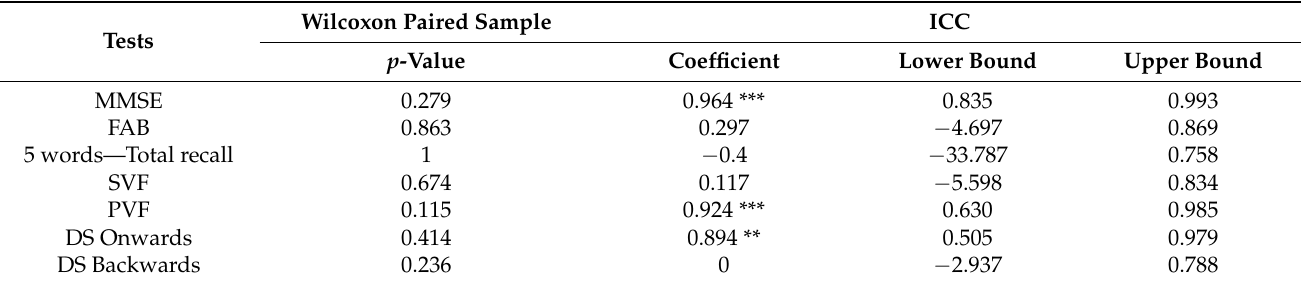
Table 3. Differences and agreement of scores between MU and FF